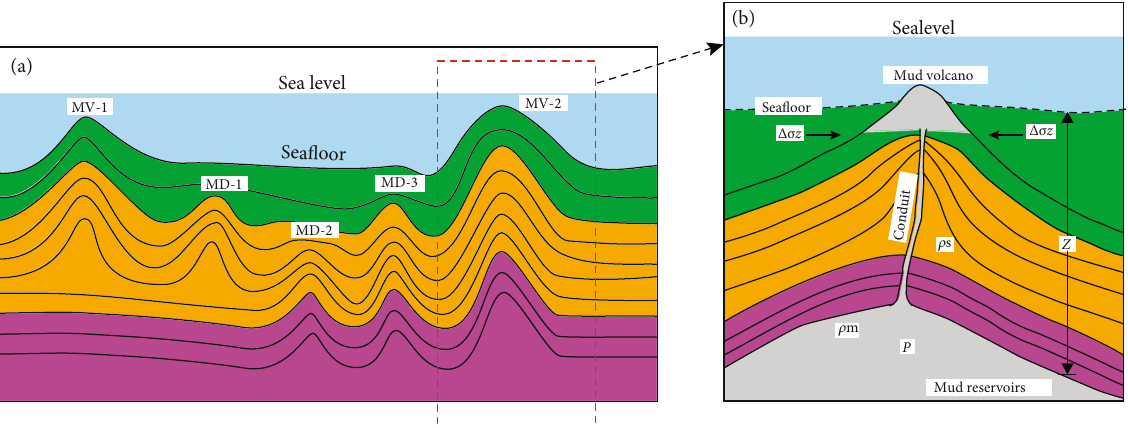
Figure 10: Pattern diagram of the formation mechanism of mud volcanoes and mud diapirs. (a) Stratigraphic pro fi le of mud volcanoes and mud diapirs. MD-1, MD-2, and MD-3 are mud diapirs, which puncture through di ff erent layers, and the source layers of MD-1 are shallower than MD-2 and MD-3. MV-1 and MV-2 are mud volcanoes, and the source layers of MV-2 are deeper than MV-1. (b) Internal structure diagram of MV-2, Z is the depth of the source, Δσ is the tectonic stress, P is the overpressure in mud reservoirs, and ρ s and ρ m are the densities of the surrounding rock and mud,